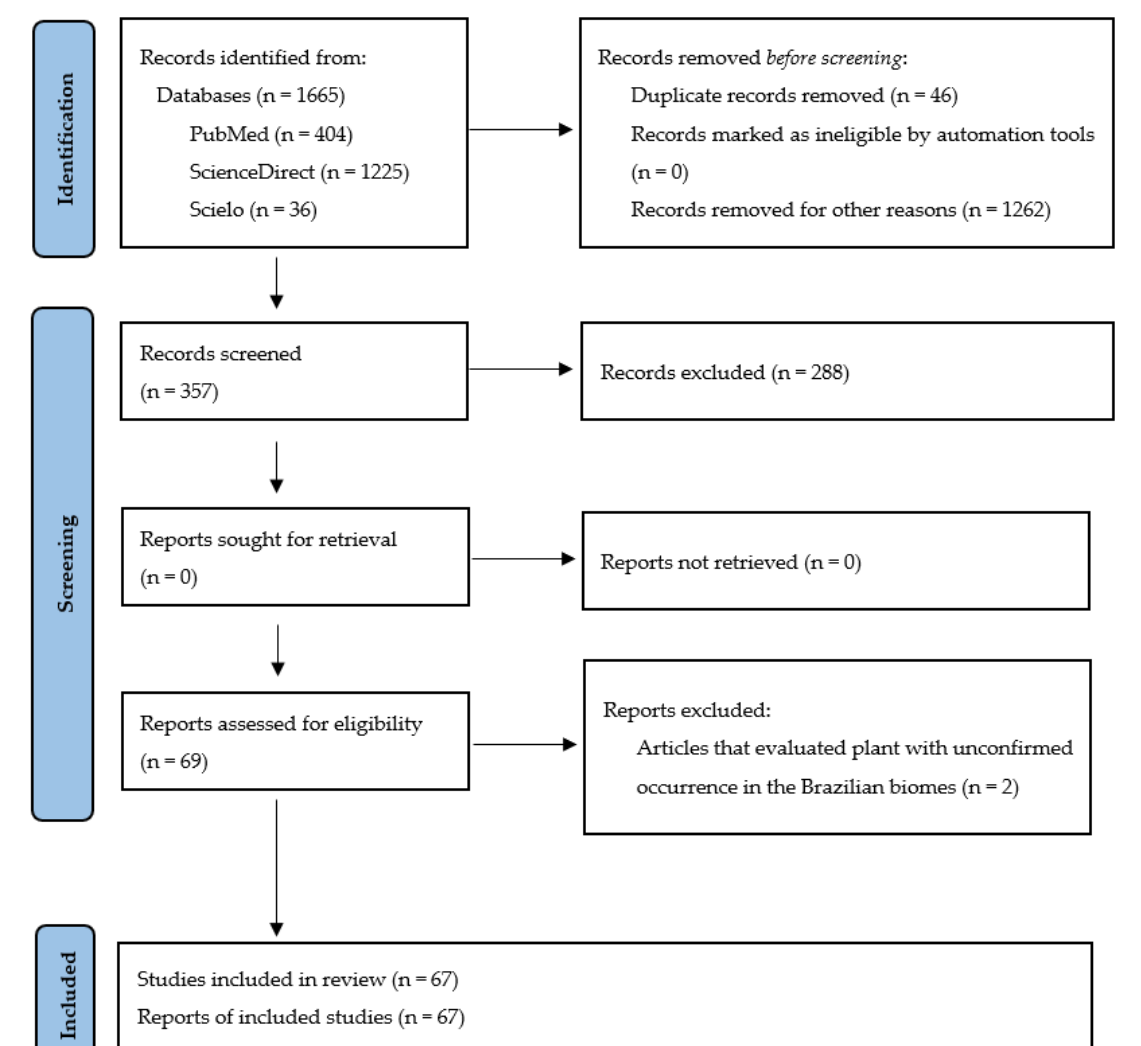
Figure 3. Flow diagram of study selection.